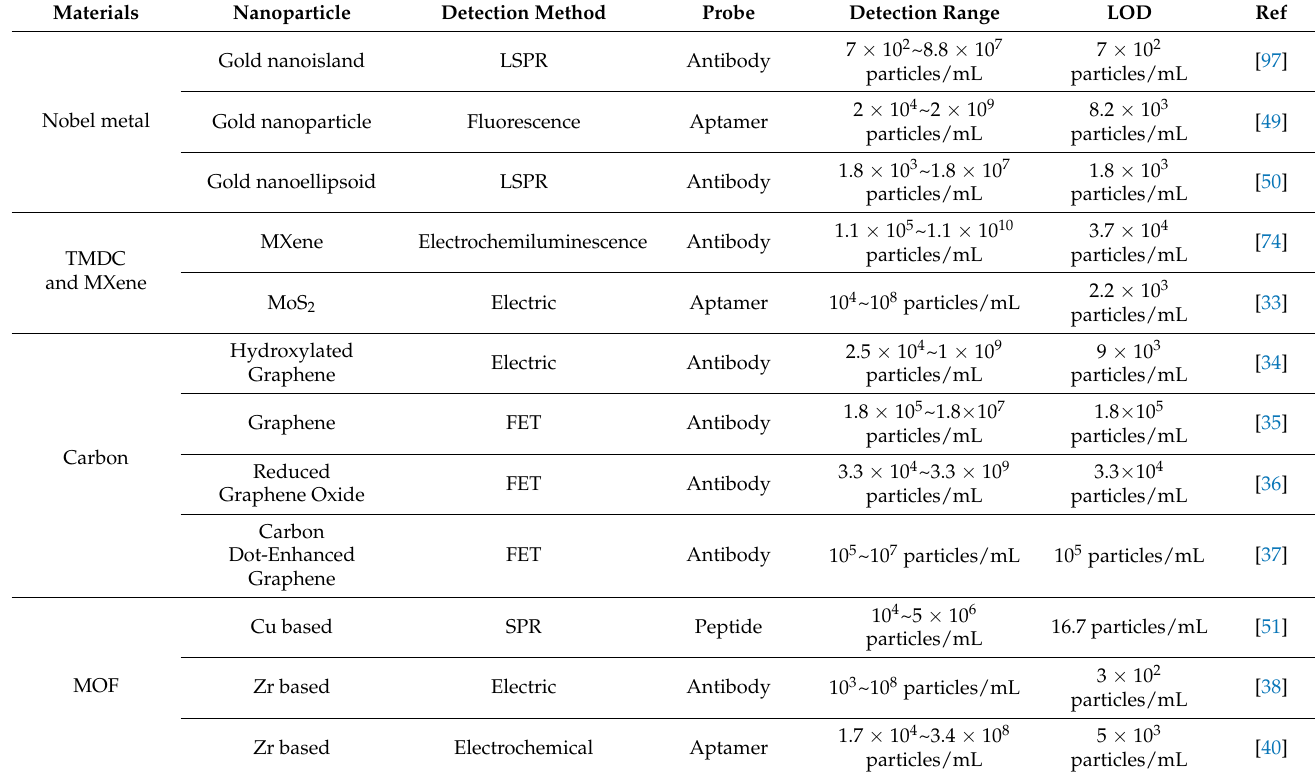
Table 1. Various nanomaterial-based exosome detection